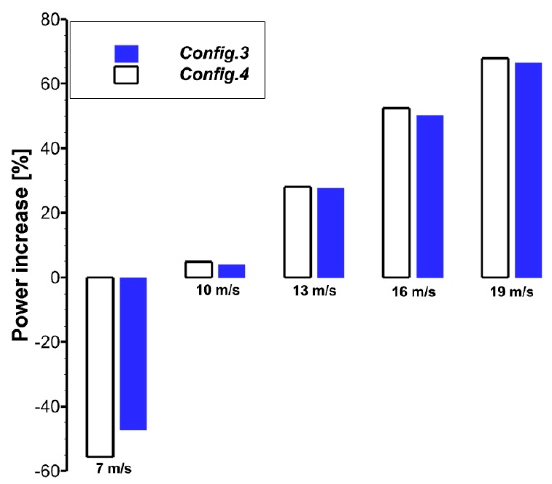
Figure 13. Second slot geometric characteristics.